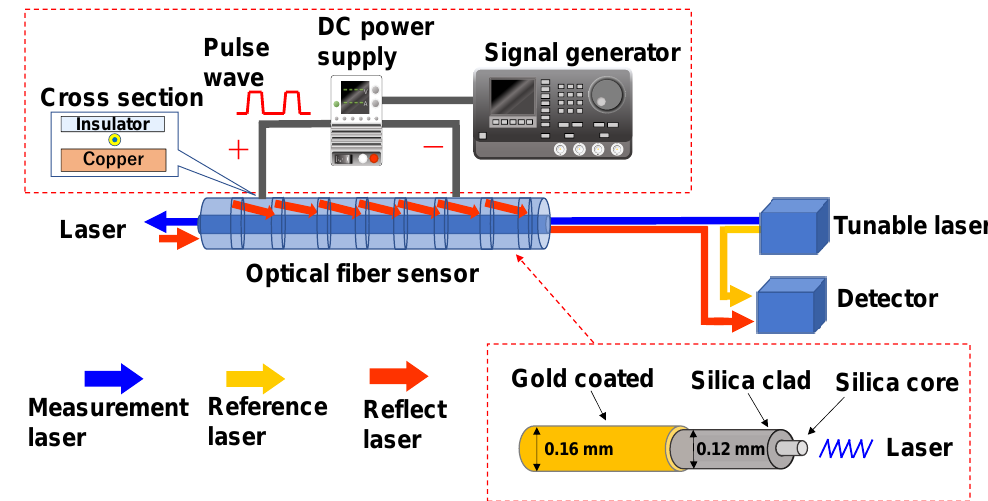
Figure 1. Schematic of the temperature and velocity measurement devices with the gold-coated optical fiber.